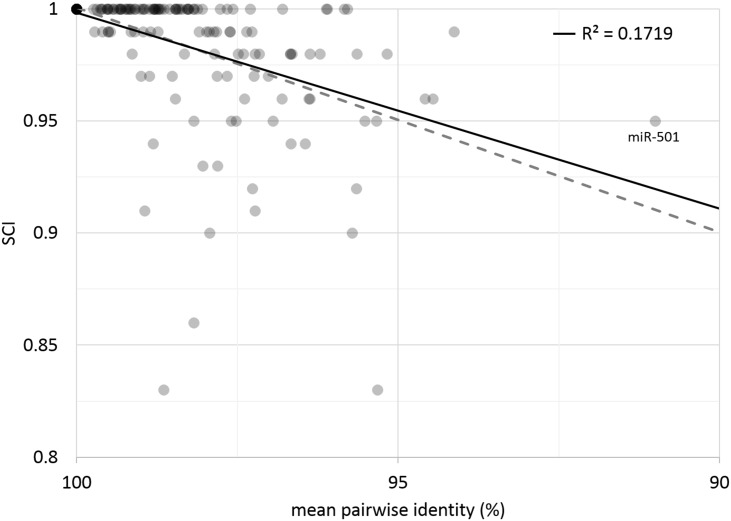
Mean pairwise sequence identity compared to the Structure Conservation Index (SCI).In general, an SCI near or above the mean pairwise identity indicates structural conservation (dotted gray line). The black line is the linear regression for our data (R2 = 0.1719).